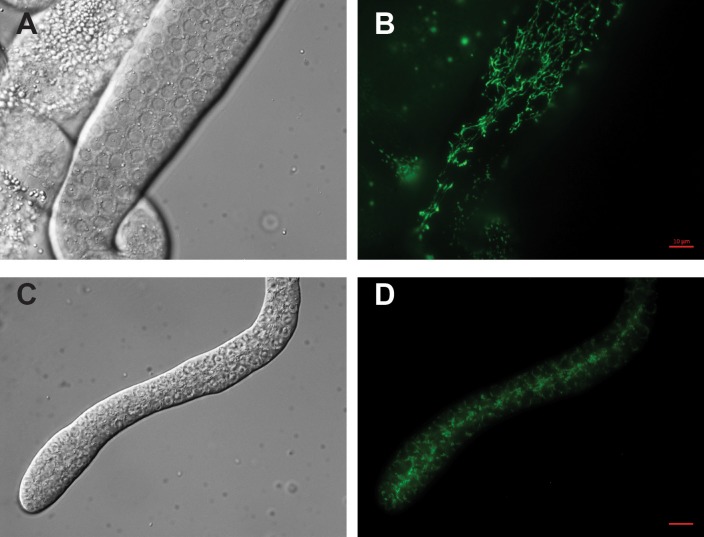
Mitochondrial localization of ALH-6 in the germline.UV integrated alh-6::gfp strain under its endogenous promoter reveals expression of ALH-6 in hermaphrodite (A–B) and male (C–D) germline. a and c are DIC images while b and d are GFP images. Scale bar for all images is 10µm.